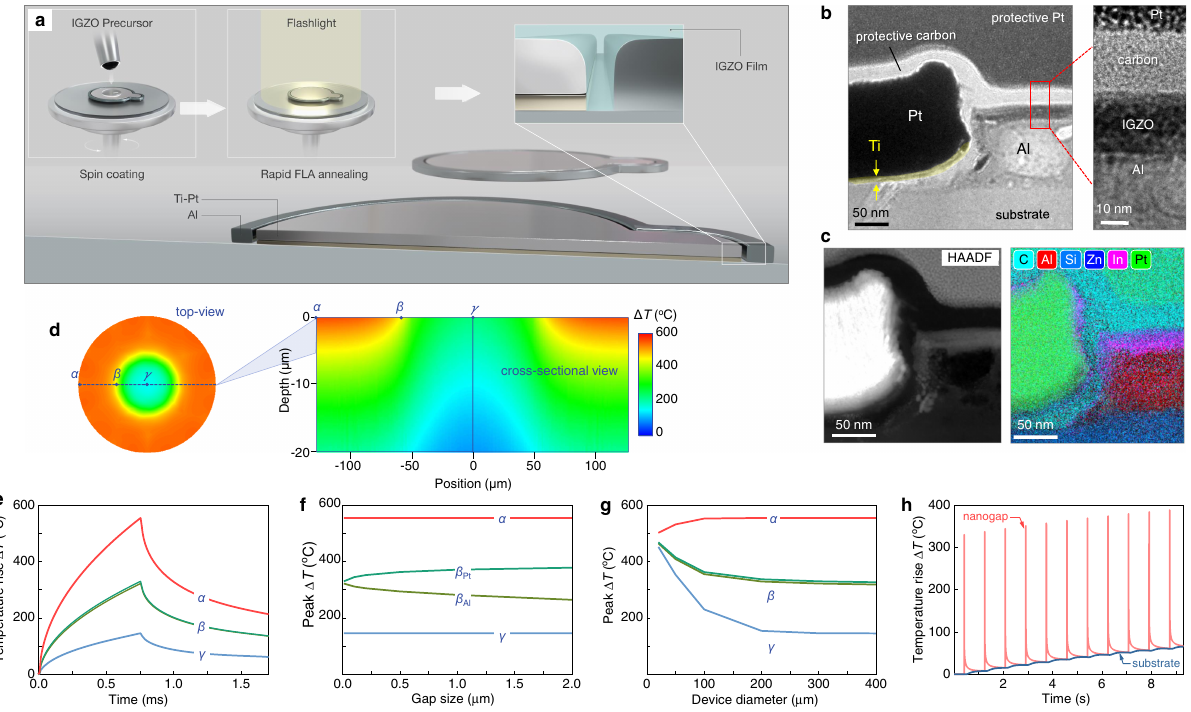
Fig. 2 Fabrication of co-planar Al/IGZO/Ti-Pt diodes via fl ash lamp annealing (FLA) route. a Schematic illustration of solution processing of IGZO fi lms on nanogap electrodes. b , c HR-TEM cross-sectional image and the corresponding EELS mapping that shows the In, Zn, and O elements within the nanogap space. d Temperature color map pro fi le on Ø300 µ m device displays the temperatures on Ti-Pt ( α ), Al ( γ ) and at the edges of the electrodes ( β ). e Time dependent temperature rise ( Δ T) plot in α , β , γ points. f The peak temperature rise as a function of lateral gap separation illustrate that at lower gap size (<30 nm) the temperature difference in channel is negligible. g Shows the peak temperature rise ( Δ T) in α , β , and γ regions with respect to inner metal diameter and it converges after 200 µ m. h Depicts the full transient including the fi rst 11 pulses arriving at 1.2 Hz repetition rate and 750 µ s pulse